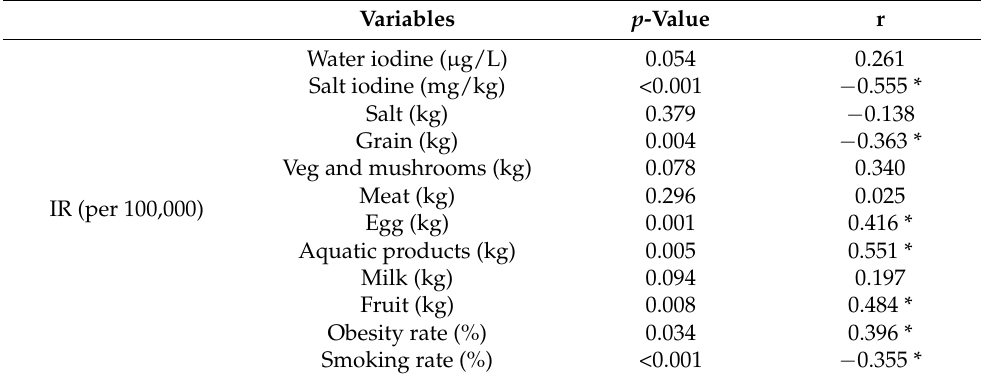
Table 4. Spearman correlation